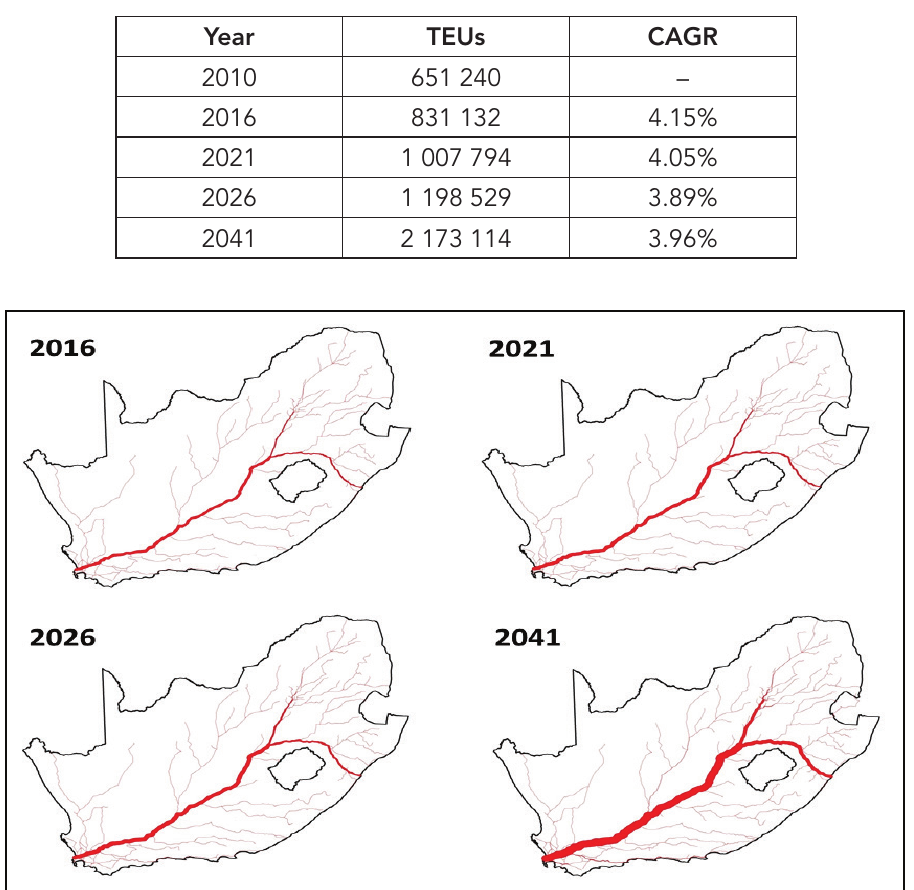
Figure 2: Forecast inland loaded container flows to and from the catchment area Table 3: Summary of base year and forecast segmented container